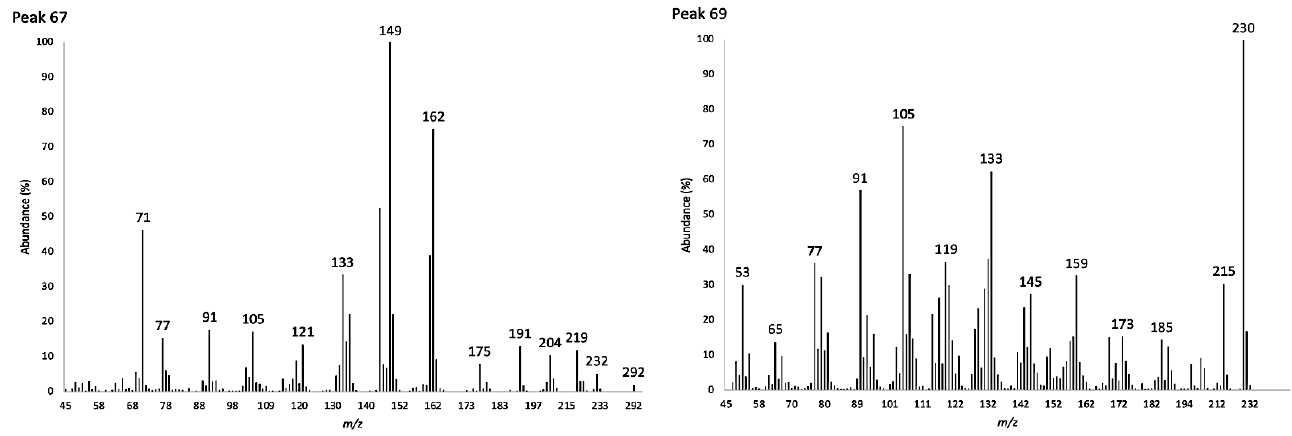
Figure 3. Electronic impact mass spectra of the unidentified compounds corresponding to peaks 67 (left) and 69 (right).